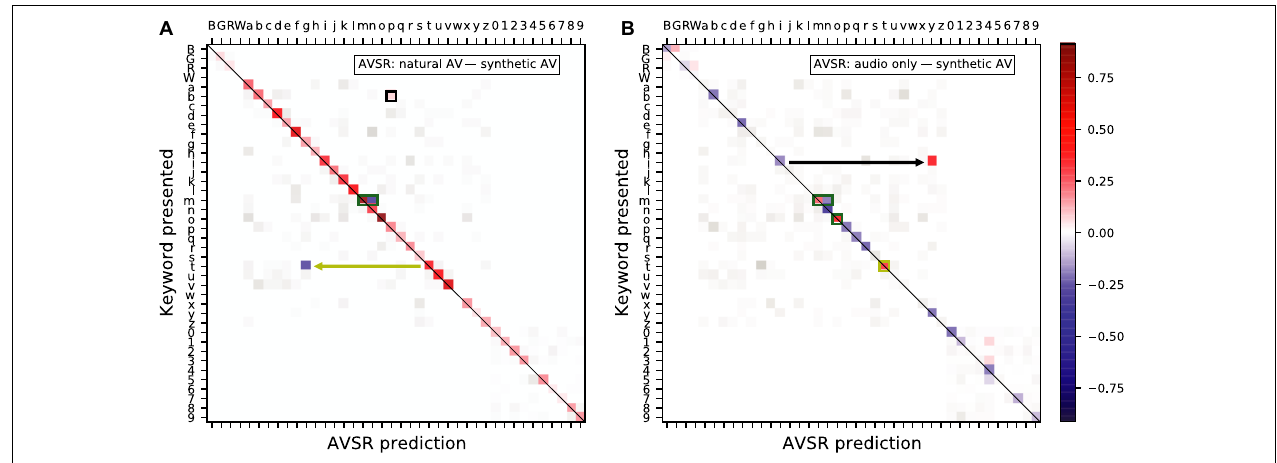
FIGURE 8 | Confusion matrices showing the difference in frequency of presented keyword and participant response pairs between (A) the natural audiovisual condition and the synthesized audiovisual condition and (B) the audio-only condition and the synthesized audiovisual condition, in the AVSR predictions. The color keywords are represented by their first letter in uppercase, those corresponding to a letter are shown in lowercase, and the number keywords by their digit. The magnitude of statistically significant pairs is highlighted in color (bootstrapped permutation test, alpha = 0.05, FDR corrected). In particular, a blue element indicates that the AVSR was significantly more likely to yield the corresponding prediction as a result of having access to a synthesized visual signal as opposed to (A) a natural video and (B) no